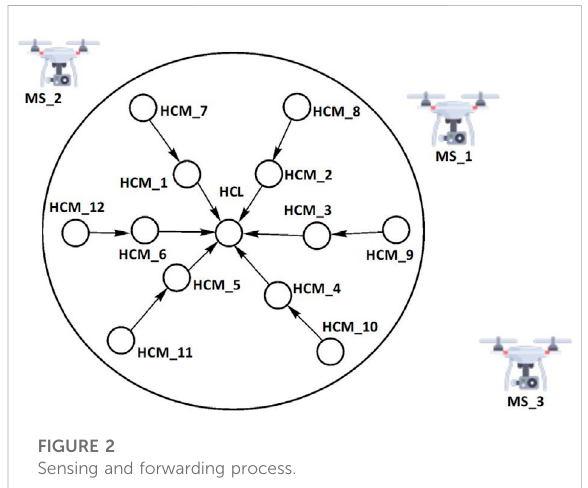
FIGURE 2 Sensing and forwarding process.